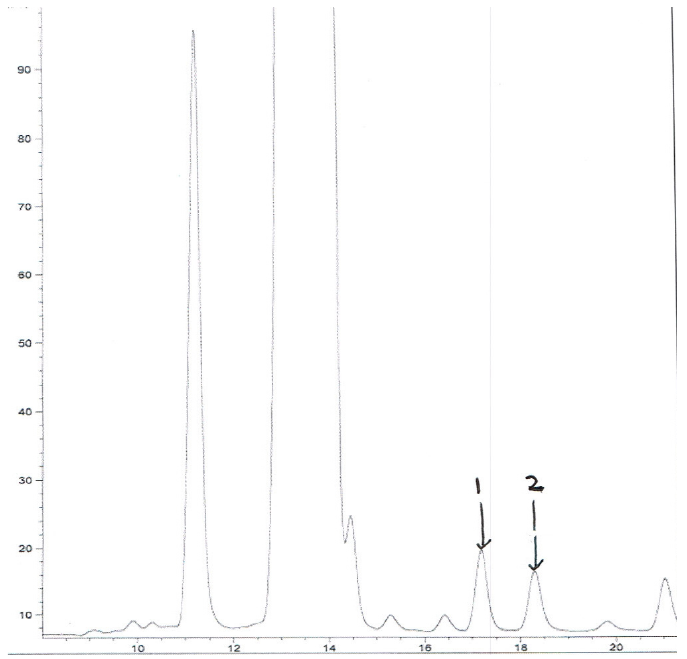
Figure 4. HPLC Trace of mixture of 1 and 2